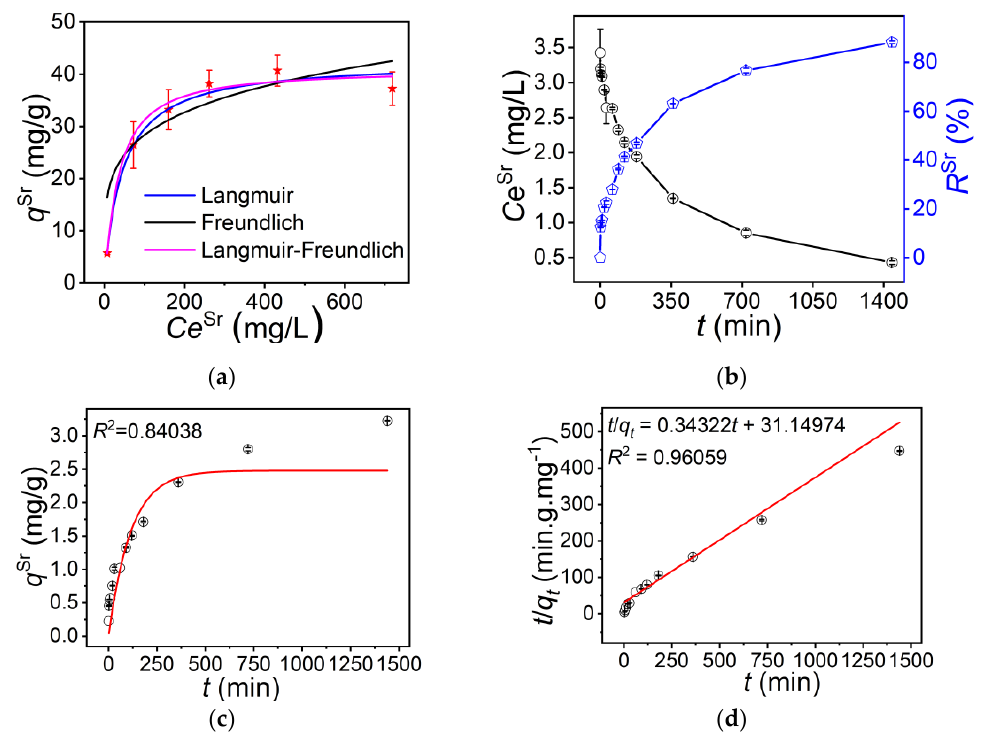
Figure 2. ( a ) The equilibrium curves of K 3 Nd(PO 4 ) 2 for Sr 2+ adsorption fitted by the Langmuir (blue line), Langmuir–Freundlich (red line), and Freundlich model (black line) isothermal adsorption models ( C 0Sr = 12.565 − 756.000 mg/L, pH = 6.03 − 6.82); ( b ) kinetics of K 3 Nd(PO 4 ) 2 plotted as Sr 2+ concentration (mg/L) (black line) and removal efficiency (%) (blue line) vs. time t (min) under neutral conditions; ( c ) the pseudo-first-order kinetic model and ( d ) the pseudo-second-order kinetic model were used to fit the Sr 2+ adsorption kinetics of K 3 Nd(PO 4 ) 2 . Table 1. The isothermal adsorption fitting results of K 3 Nd(PO 4 ) 2 for Sr 2+ .